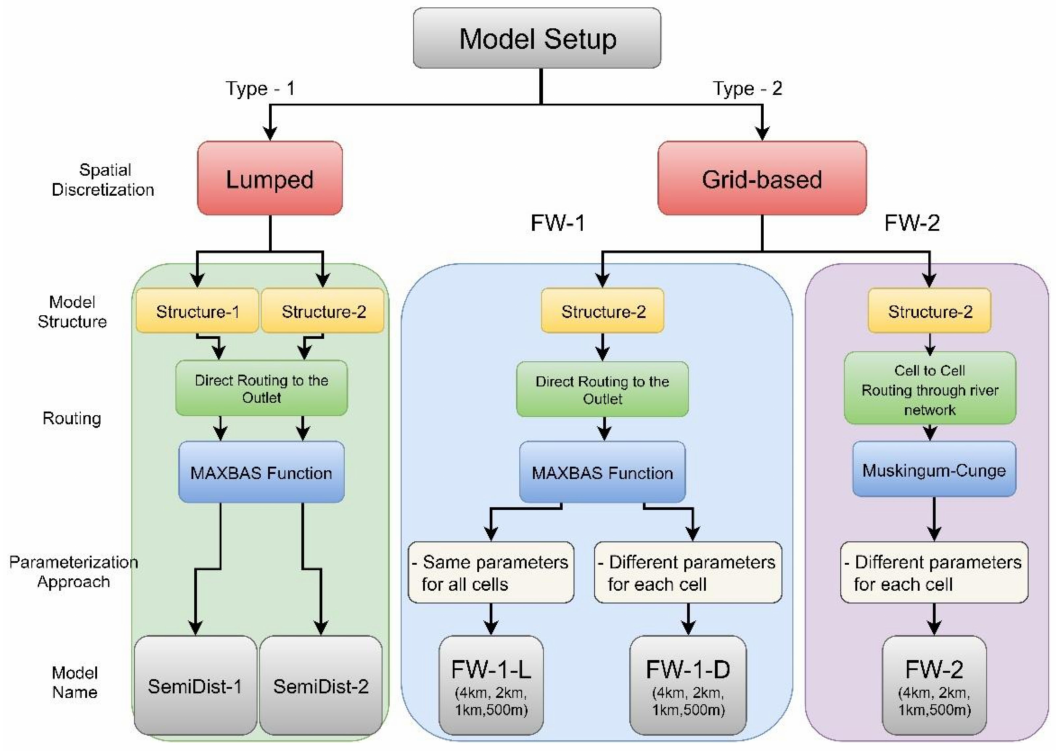
Figure 10. Model